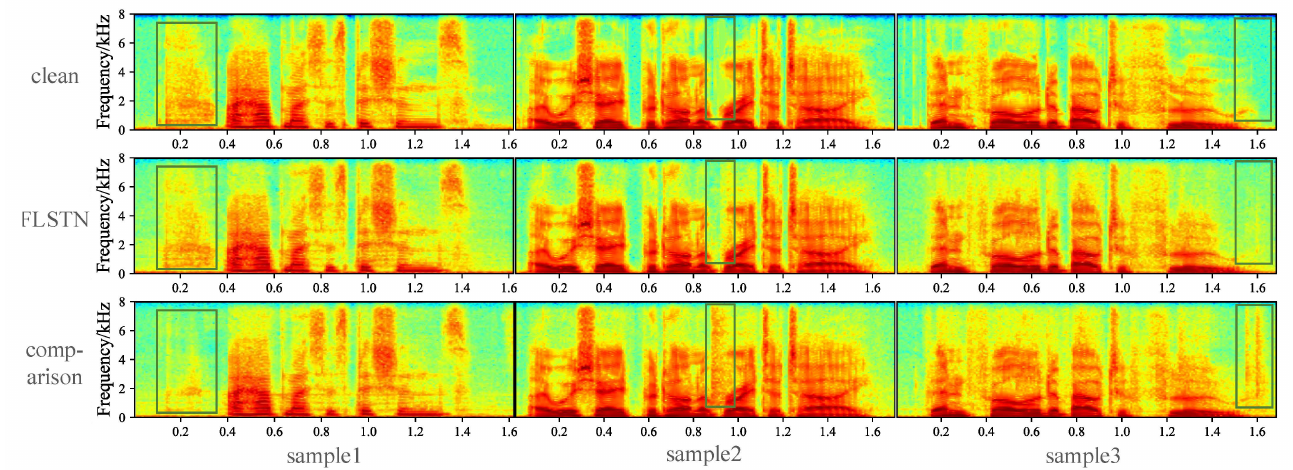
Figure 6. Enhanced spectrograms of FLSTN and comparison model (samples are saved at 16